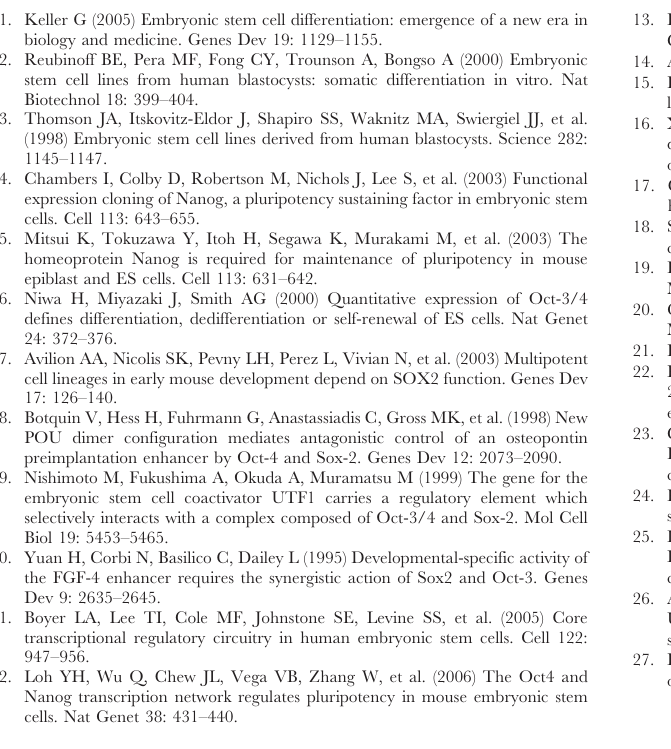
Table S3 Differential expression levels and evolutionary conser- vation of hES cell-specific miRNAs during embryoid body (EB) formation. miRNA expression was analyzed in hES cells and EBs after 14 days of differentiation. miRNA expression is arranged by log2 ratio in hES cells/EBs (EB/ES) for 30 of , 276 miRNAs whose log2 ratio . 1. miRNA conservation in various species was determined as described in Table